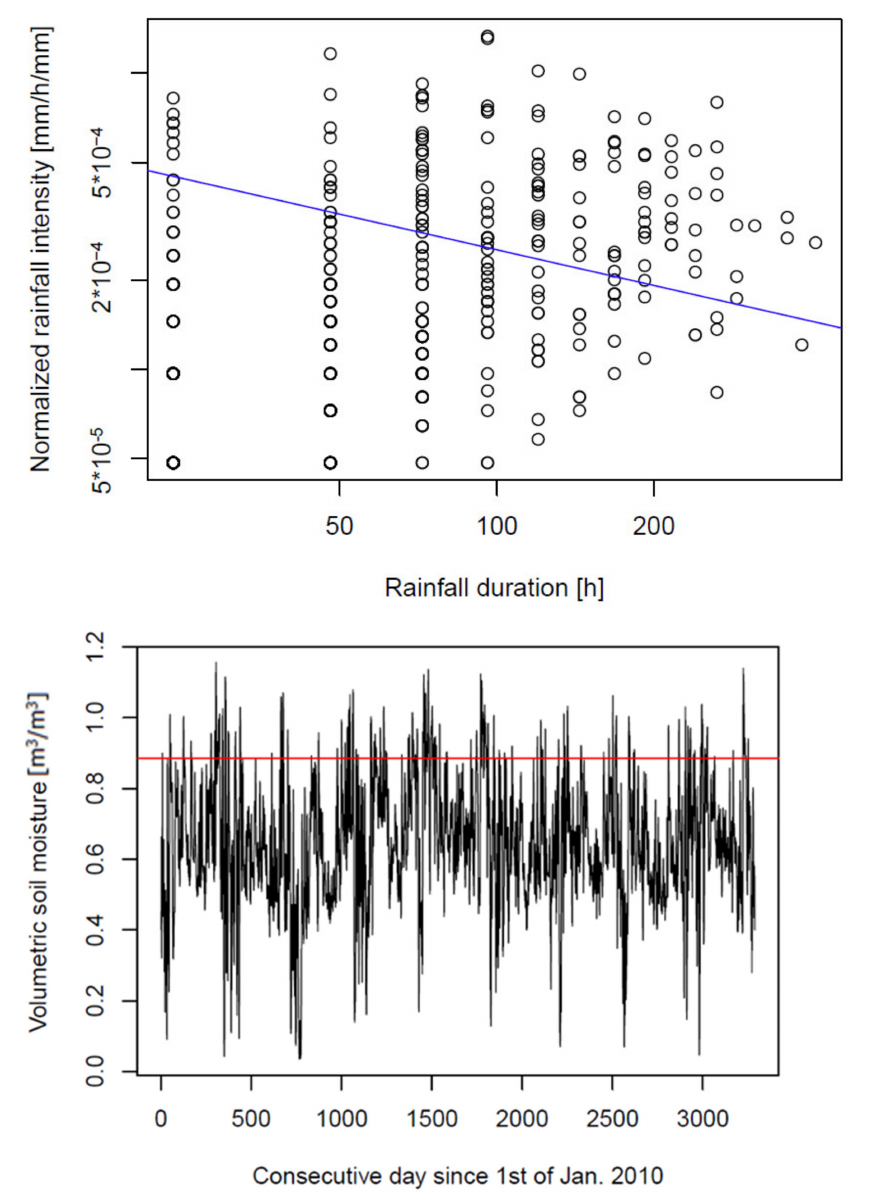
Figure 4. Example of “regional” empirical rainfall threshold using Equation (1) and simple 90% percentile volumetric soil moisture (VSM) threshold. It should be noted that the sum of 3 days VSM values are shown in Figure